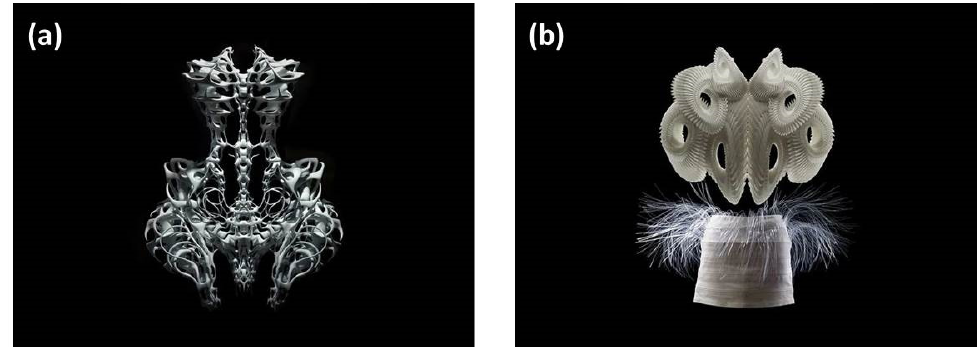
Figure 1. Iris van Herpen’s 3D-printed clothing from 2010 ( a ) and 2011 ( b ) in high-definition series [24].